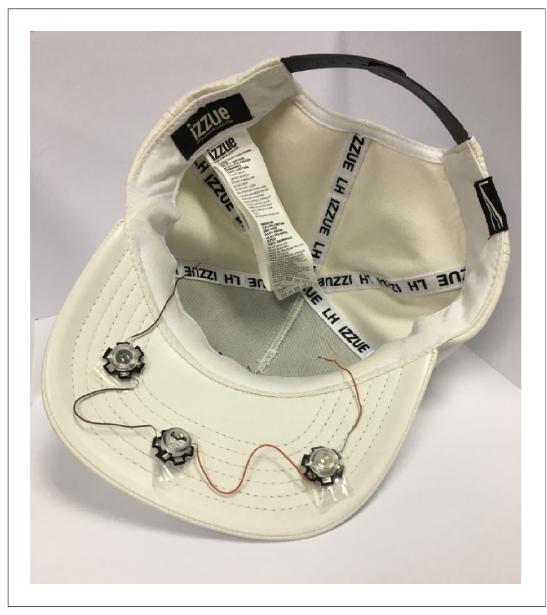
Figure 14. The cap with some infrared LED (Image Credit: Zhou et al.